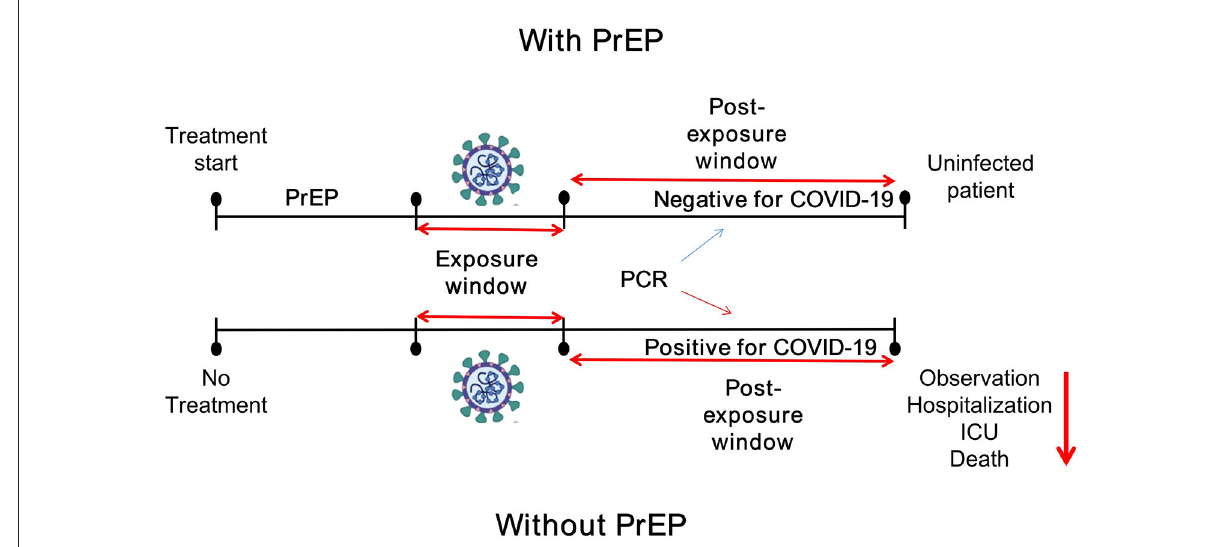
FIGURE1 Comparison of SARS-CoV-2 PrEP strategies and post infection therapy. With an effective PrEP strategy, the patient remains negative for COVID-19 as SARS-CoV-2 cannot replicate in the patient’s body. Conversely, without a PrEP strategy, any exposure to SARS-CoV-2 can result in an infection, confirmed by a positive PCR test. In the optimal scenario, the patient will develop a mild infection which will be subsequently controlled and eliminated by their immune response. ICU, intensive care